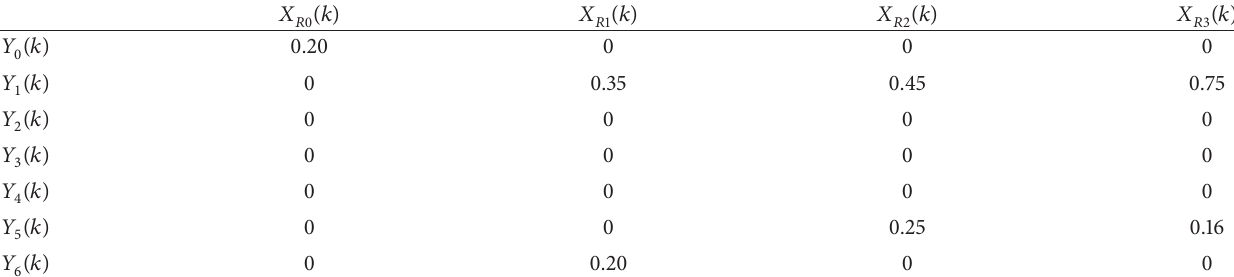
of the sensitivity of reactive stimuli. OF